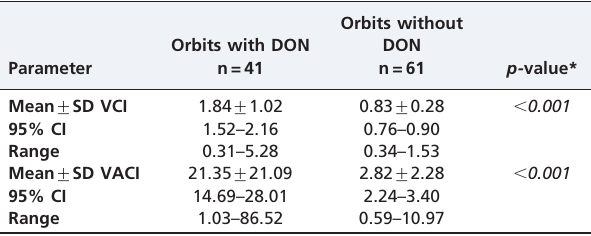
Table 1 - Means ¡ standard deviation of the axial volumetric orbital crowding index (VCI) and the coronal volumetric orbital apex crowding index (VACI) in the orbits of patients with Graves’ orbitopathy (GO) with or without dysthyroid optic neuropathy (DON).